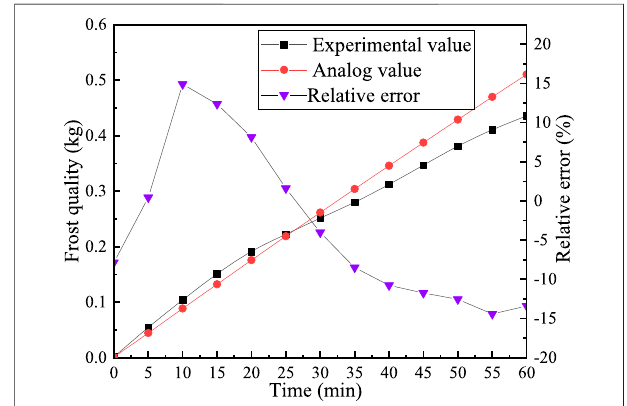
FIGURE 6 | Comparison of the experimental value and simulated value of frost